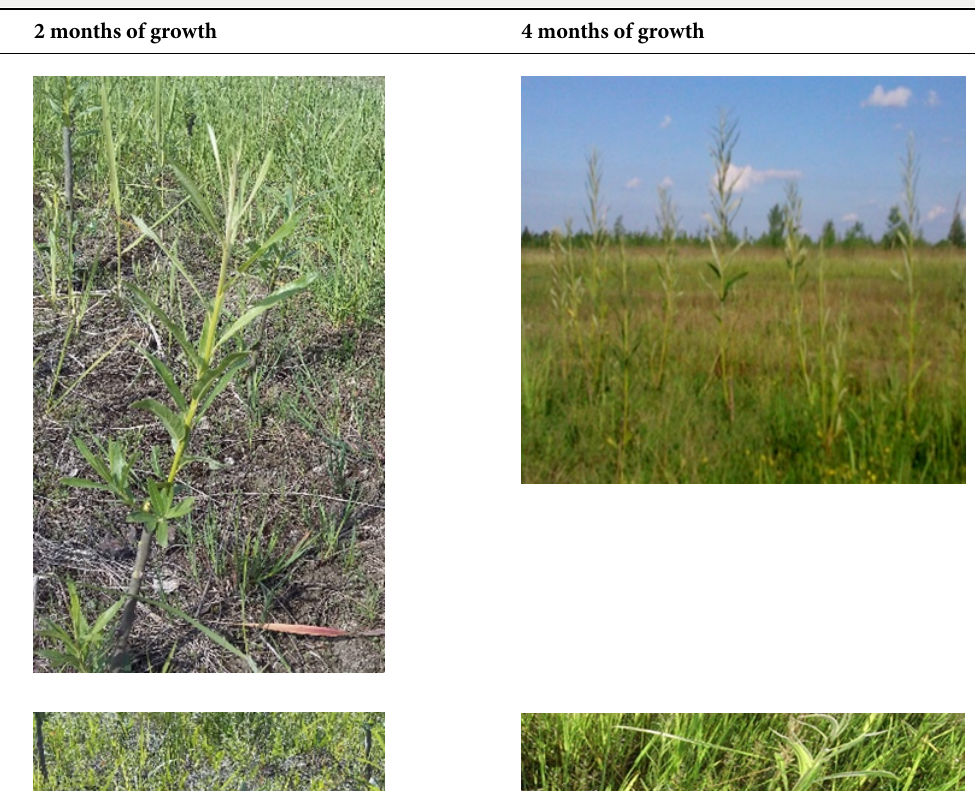
Table 3 Growth of Salix viminalis at the Stebnyk tailing, control and experimental plots.